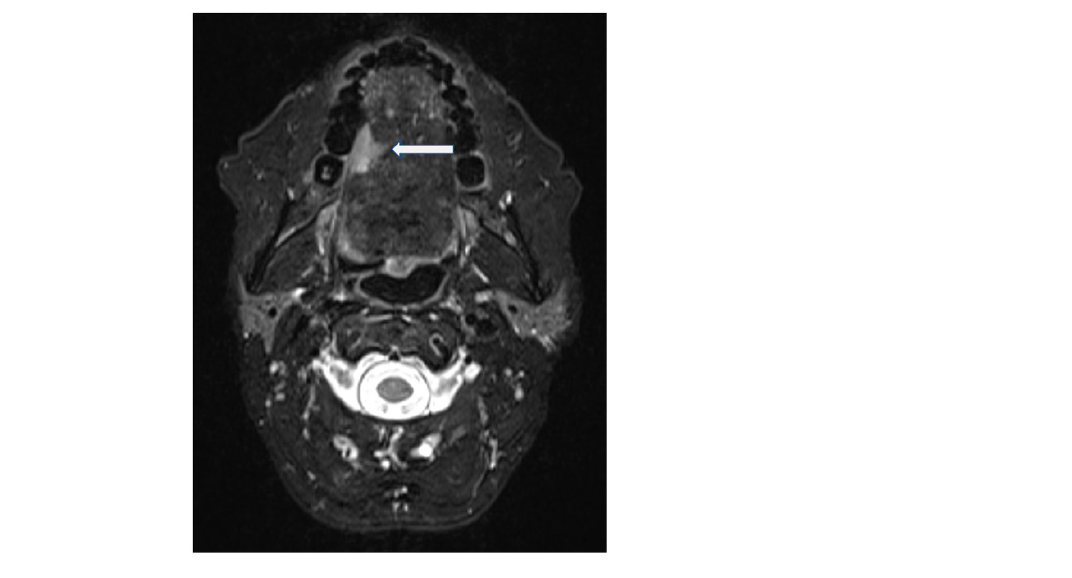
Figure 3. T2-weighted fat-suppressed, contrast-enhanced MRI of Case 2 in the axial plane. Squamous cell carcinoma indicated by arrow.